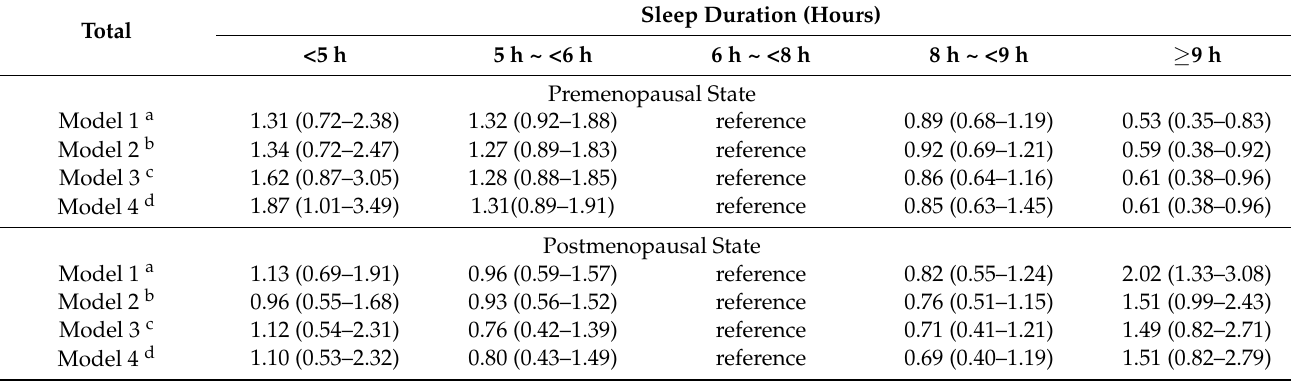
Table 4. Crude and adjusted odds ratios for sleep duration associated with anemia stratified menstrual status in